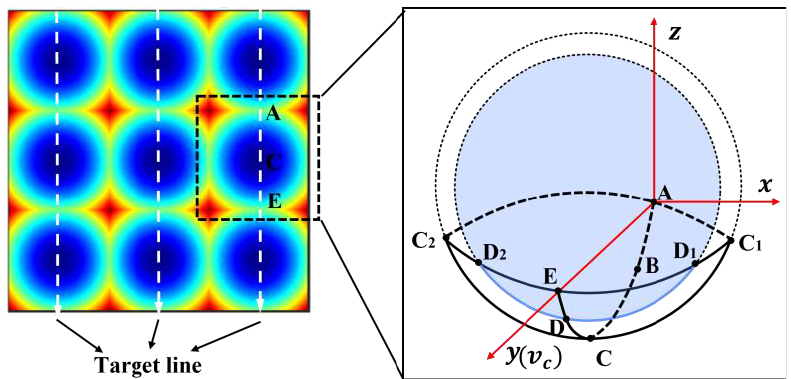
Figure 3. A schematic diagram of diamond sculpturing of microlens array.